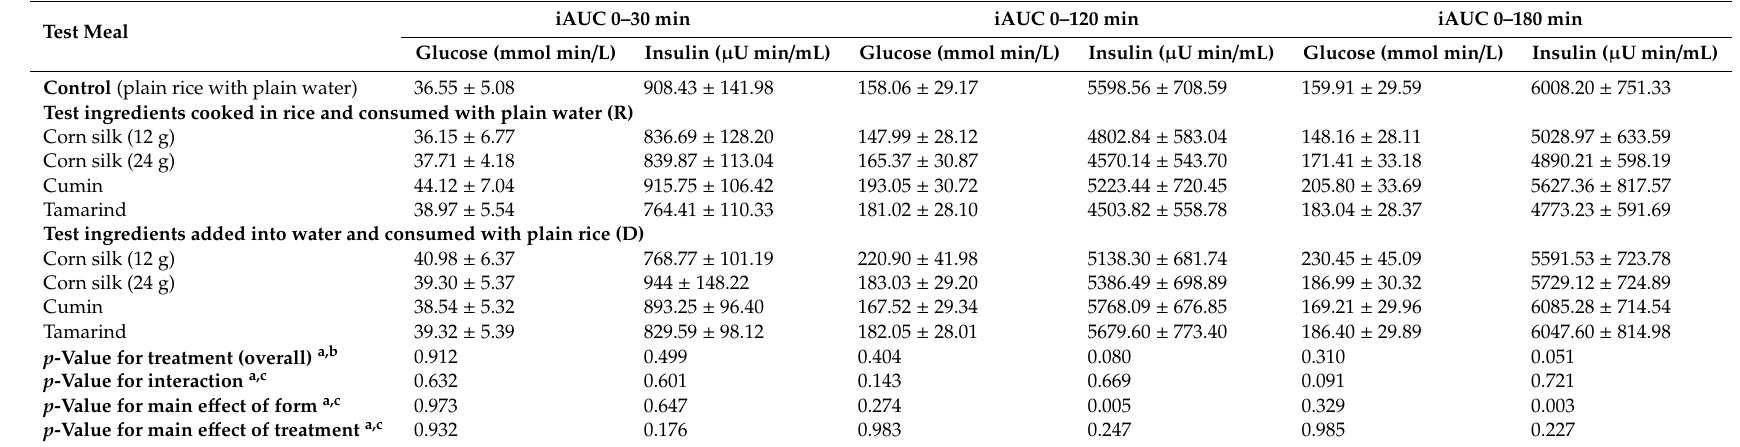
Table 3. Incremental areas under the curve (iAUCs) for postprandial glucose and insulin over relevant time periods during various